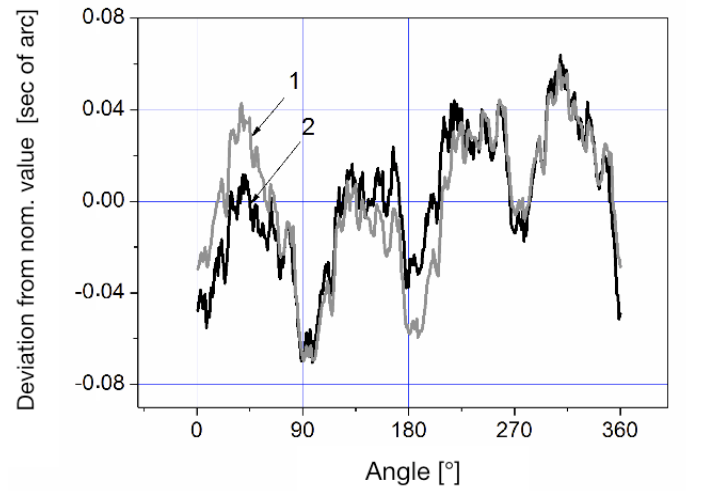
Figure 7. Results of the RON-905 calibration at the German National Metrological Institute (PTB) (1) and LDG